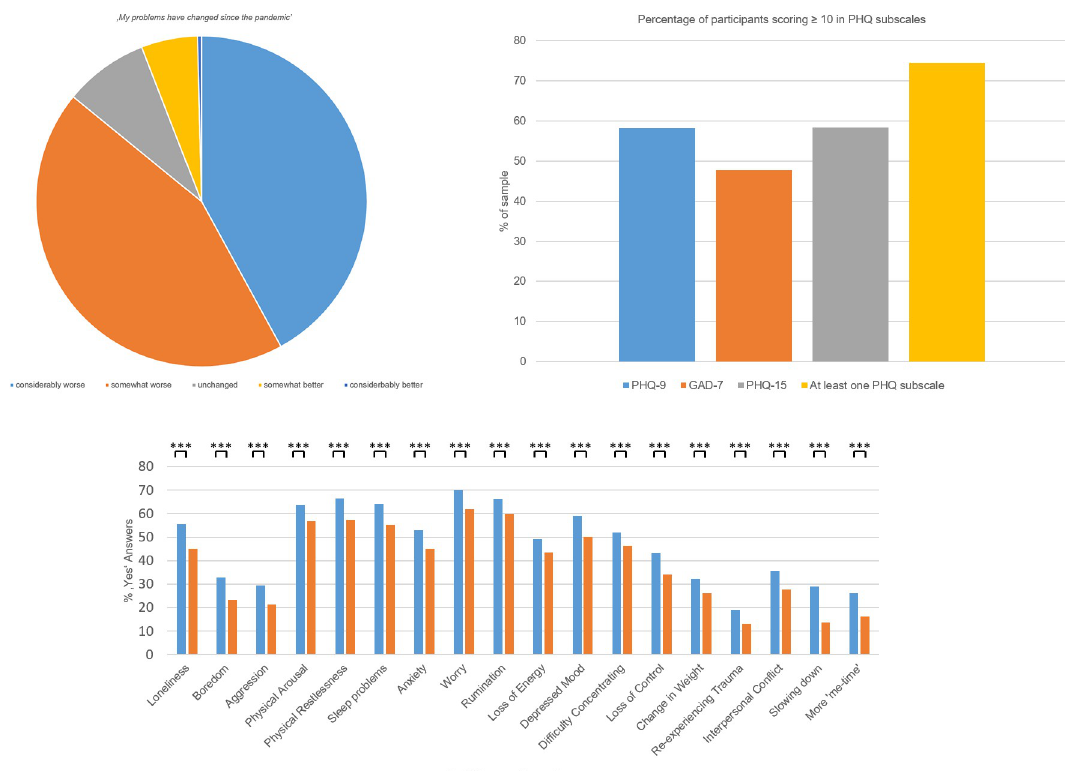
Fig 1. Ratings of psychological distress and clinical scores. Change in mental health problems due to the pandemic in the sample (valid answers only, without N/As; upper). Percentage of participants scoring ten or above across the primary outcomes (middle). Percentage of affective states reported as occurring during the first wave of the COVID-19 pandemic and currently (all categories negative except for the right outer two, lower). Here, all comparisons between both time-points were highly significant ( ��� p < 0.001, all